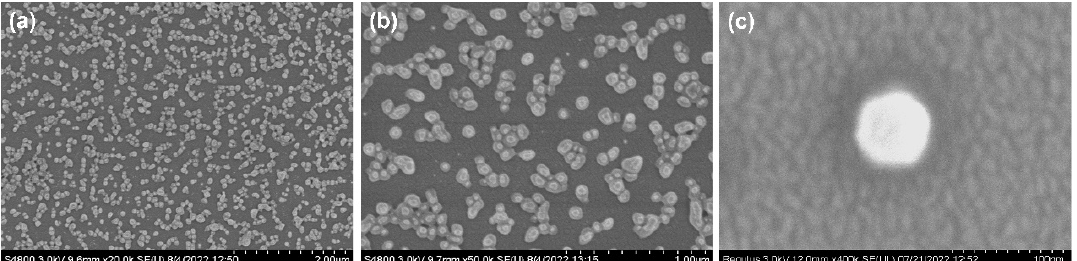
Figure 2. SEM images of nanocapsules examined at different configurations: ( a ) 20,000×, ( b ) 50,000×, and ( c ) 400,000×.